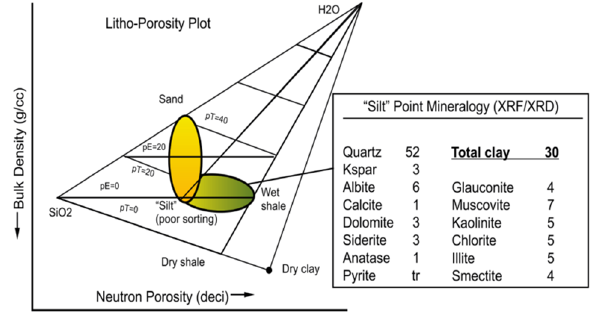
Fig. 1 Neutron-density cross-plot representing sand–silt–clay boo- merang shape and XRF/XRD for core samples in the Malay Basin (Heavysege